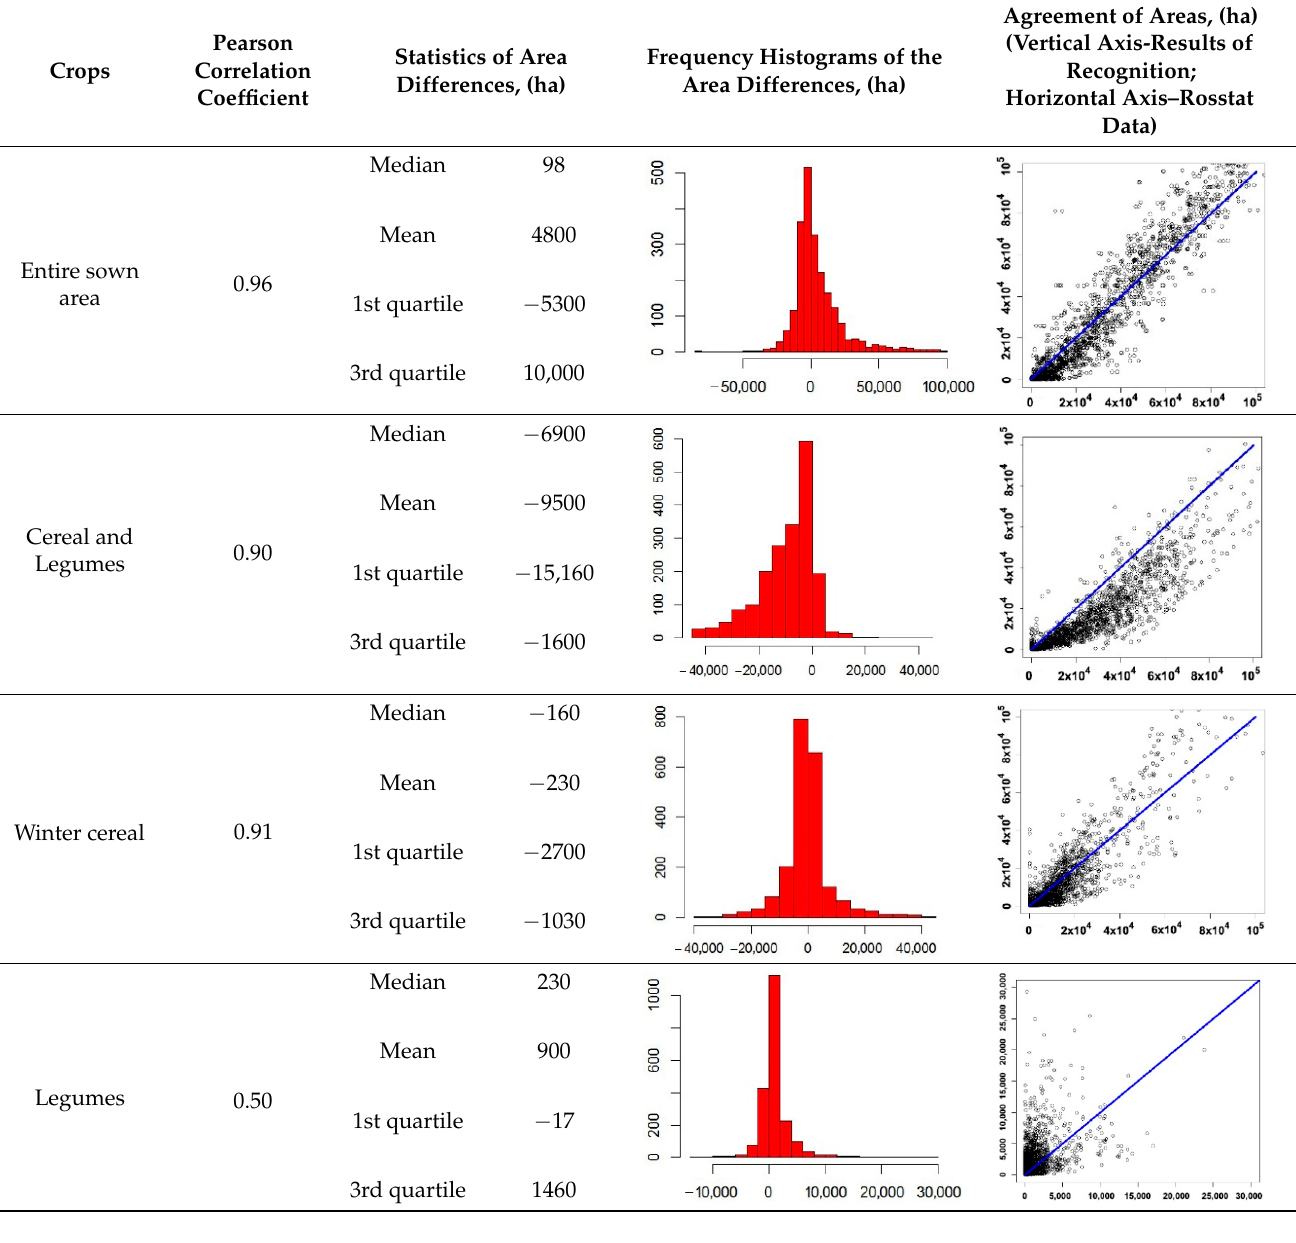
Table 2. Agreement of crop areas estimated based on the recognition results and according to Rosstat data for 1120 municipalities. Crops Entire sown